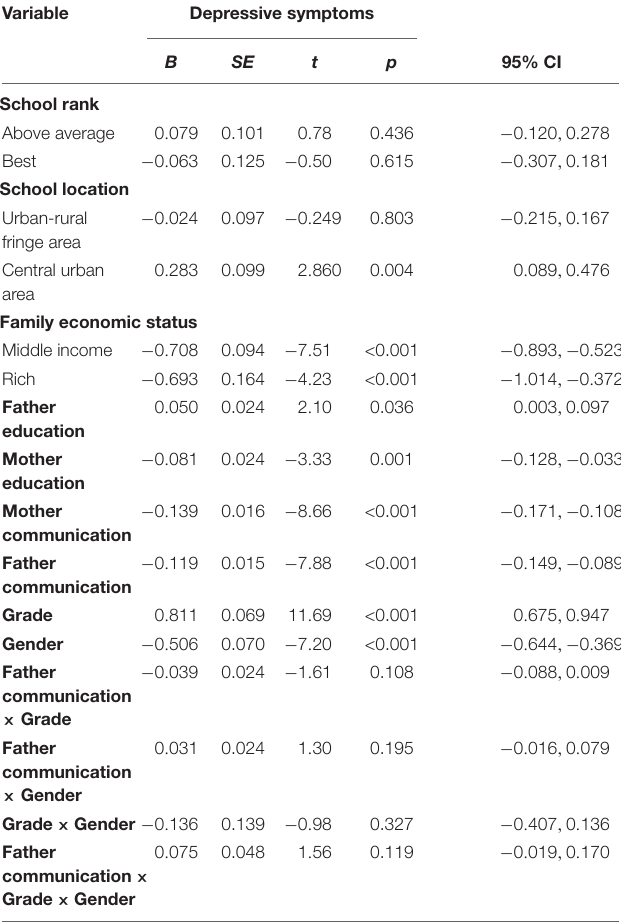
CI, confidence interval. Grade: 0 = 7th grade, 1 = 9th grade; Gender: 0 = girl, 1 = boy. Reference group: Medium and below on School rank; town and country on School location; poor family on Family economic